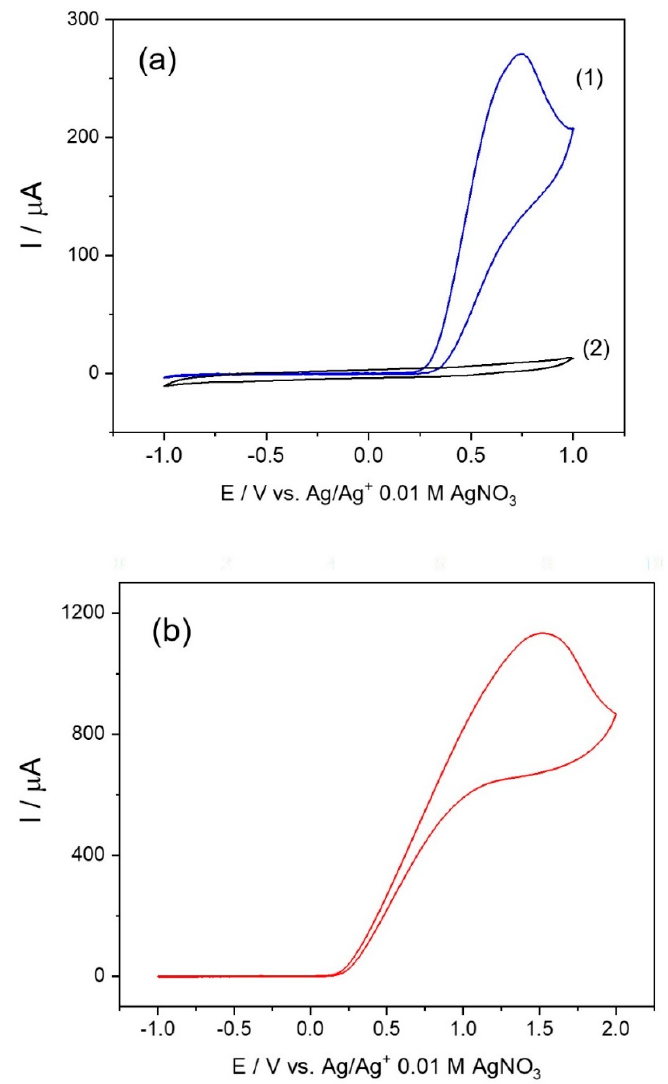
Figure 9. Cyclic voltammograms at the scan rate of 100 mV / s for ( a ) (1) the formation of the [Ni(TEA) 2 ] 2 + complex by adding 0.2 M Ni(NO 3 ) 2 · 6H 2 O into 0.4 M TEA (1:1 by volume) compared to (2) 0.2 M Ni(NO 3 ) 2 · 6H 2 O and ( b ) 0.2 M TEA in ethanol. Note that 0.1 M LiClO 4 in ethanol was used as the electrolyte.